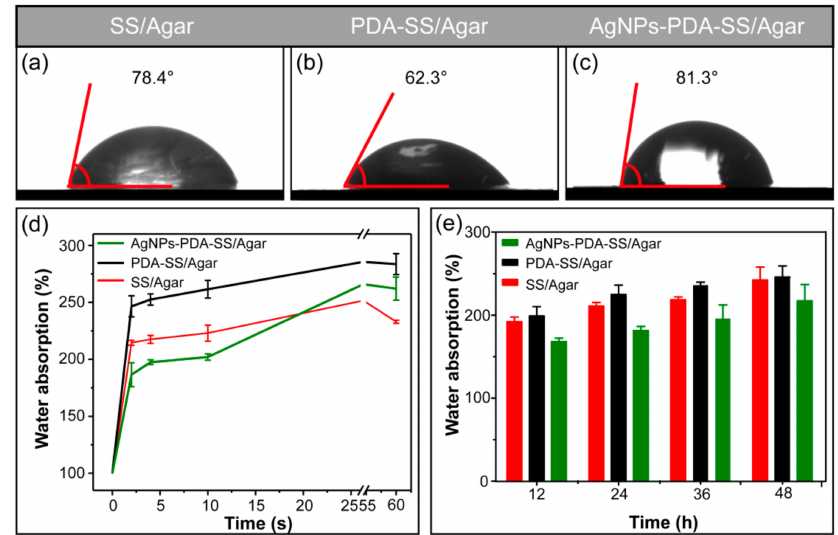
Figure 5. Water contact angle of SS/Agar ( a ), PDA-SS/Agar ( b ), AgNPs-PDA-SS/Agar films ( c ) and water absorption of different films ( d , e ).